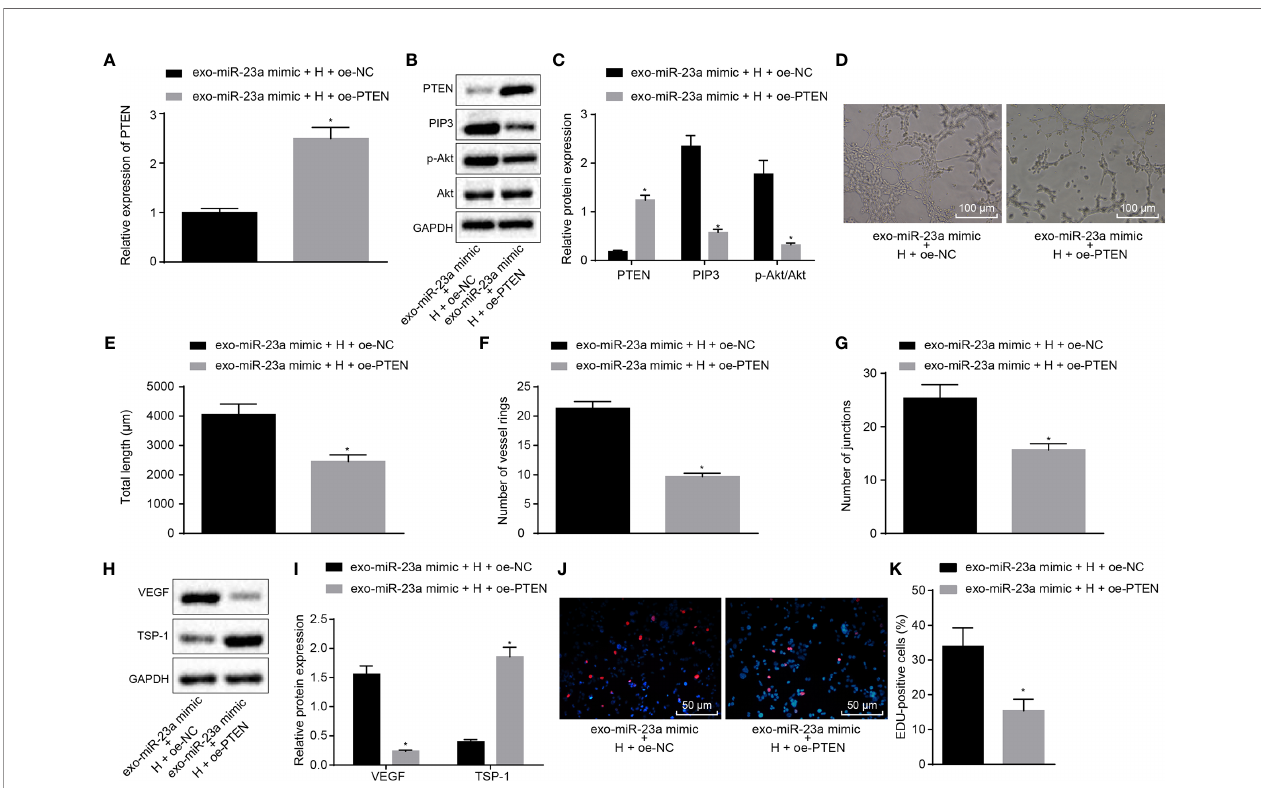
FIGURE 6 | GC cell-derived exosomal miR-23a accelerates angiogenesis through inhibition of PTEN expression. (A) Determination of PTEN mRNA expression by RT-qPCR. (B, C) Western blot analysis of PTEN, PIP3, phosphorylated Akt and Akt proteins. (D) Representative images of the tube formation in HUVECs (×100). (E – G) The tube length, number of loops and nodes in HUVECs. (H,I) Western blot analysis of VEGF and TSP-1 proteins in HUVECs. (J, K) The proliferation of HUVECs assessed by EdU assay (×200). *p < 0.05 vs. HUVECs co-cultured with exosomes derived from miR-23a-mimic and oe-NC-transfected HGC-27 cells. Measurement data were expressed as mean ± standard deviation. If the data were in compliance with normal distribution and homogeneity, comparisons between two groups were conducted using unpaired t-test. The experiment was repeated three times